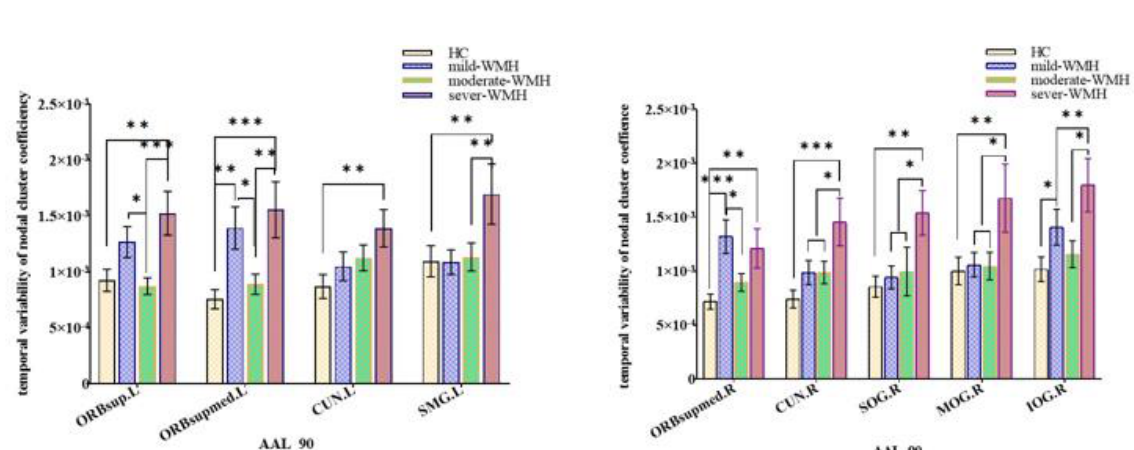
Figure 3. Group comparisons of the temporal variability of the nodal cluster coefficiency. Right cuneus (CUN.R), right medial orbital part of superior frontal gyrus (ORBsupmed.R), right superior occipital gyrus (SOG.R), right middle occipital gyrus (MOG.R), right inferior occipital lobe (IOG.R), left cuneus (CUN.L), left medial orbital part of superior frontal gyrus (ORBsupmed.L), left orbital part of superior frontal gyrus (ORBsup.L), and left supramarginal gyrus (SMG.L). *** significant at 0.001 level, ** significant at 0.01 level, and * significant at 0.05 level